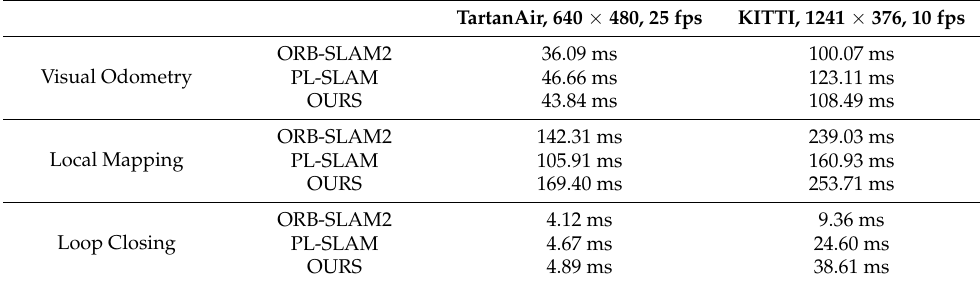
Table 4. Average runtime of each part of the